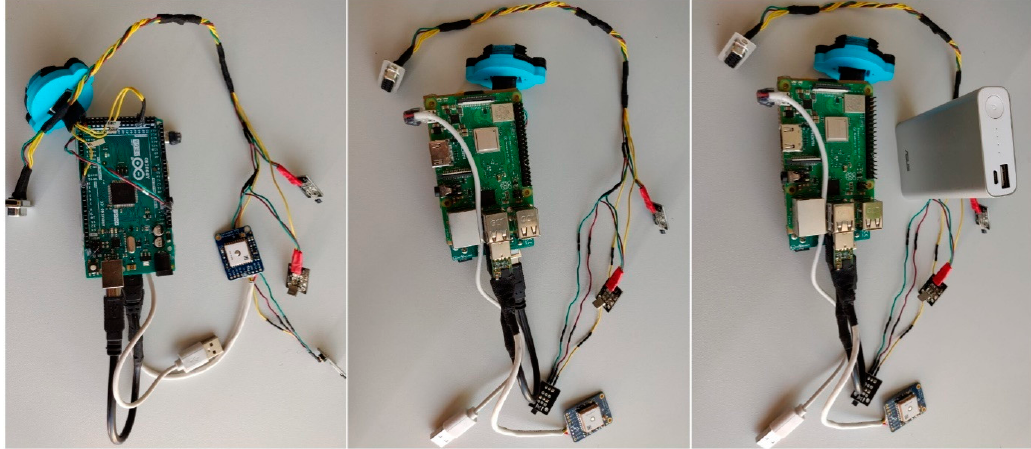
Figure 16. The resulted bicycle frame module.